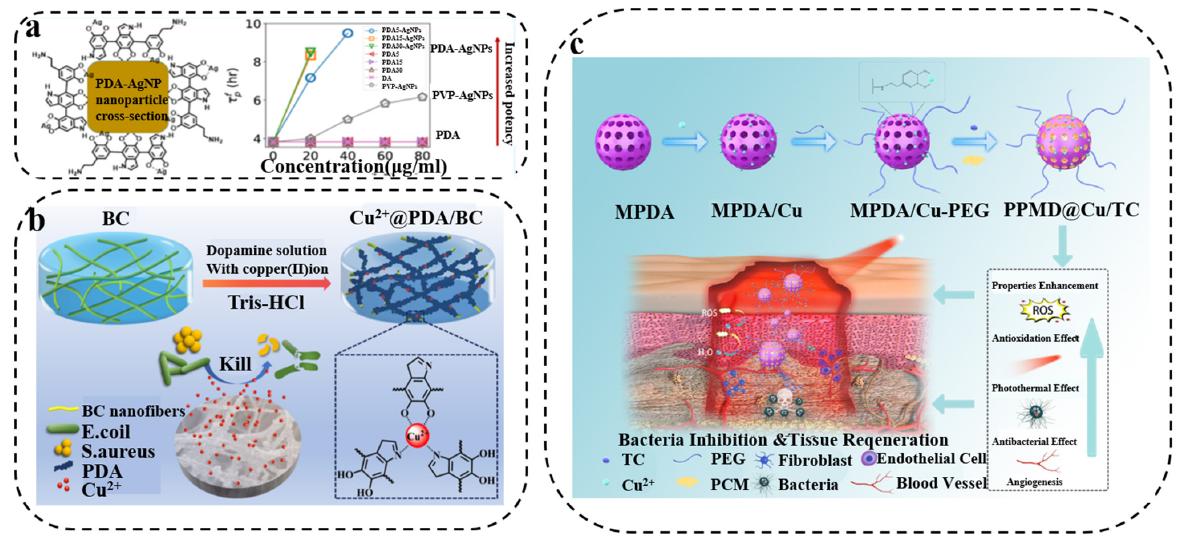
Figure 4. ( a ) Schematic illustration of the PDA deposition on PVP-AgNPs to form PDA-AgNPs. Reprinted with permission from [74] (copyright: American Chemical Society, 2020). ( b ) Schematic diagram of the preparation of Cu 2+ @PDA/BC composites. Reprinted with permission from [77] (copyright: Elsevier, 2021). ( c ) Schematic diagram of polydopamine nanocomposites loaded with Cu 2+ , phase change materials and tetracycline(PPMD@Cu/TC). Reprinted with permission from [78] (copyright: American Chemical Society, 2022).